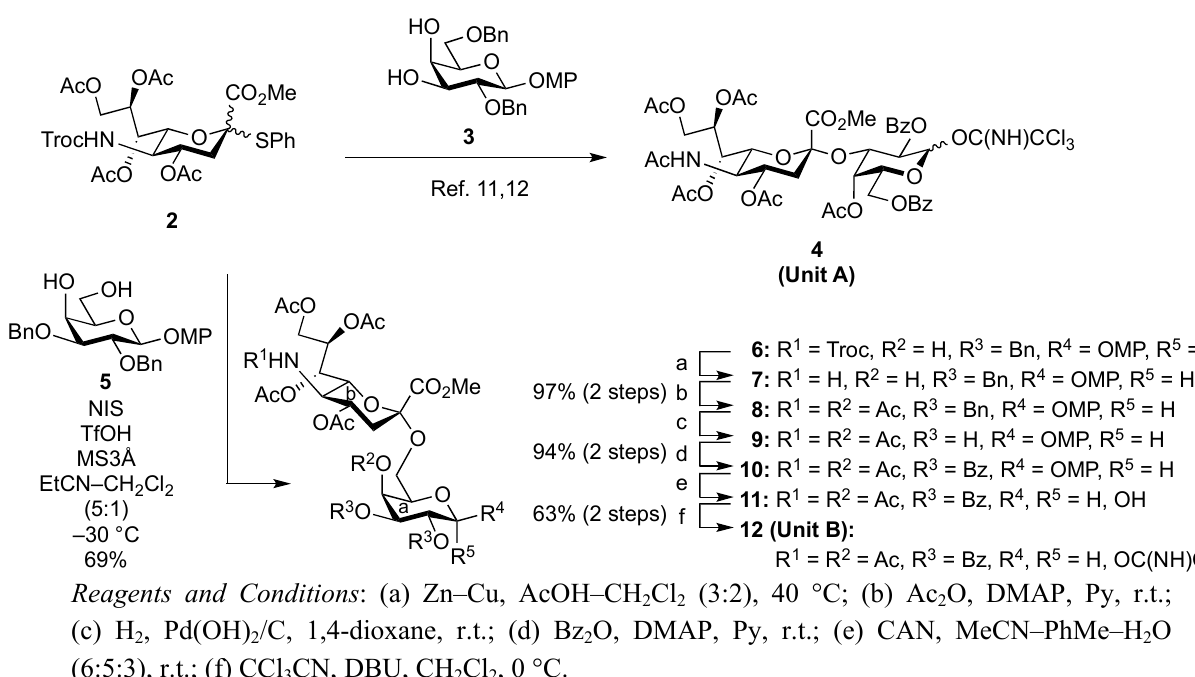
Scheme 1. Efficient synthesis of Units A and B from the N -Troc-protected sialyl donor 2 .